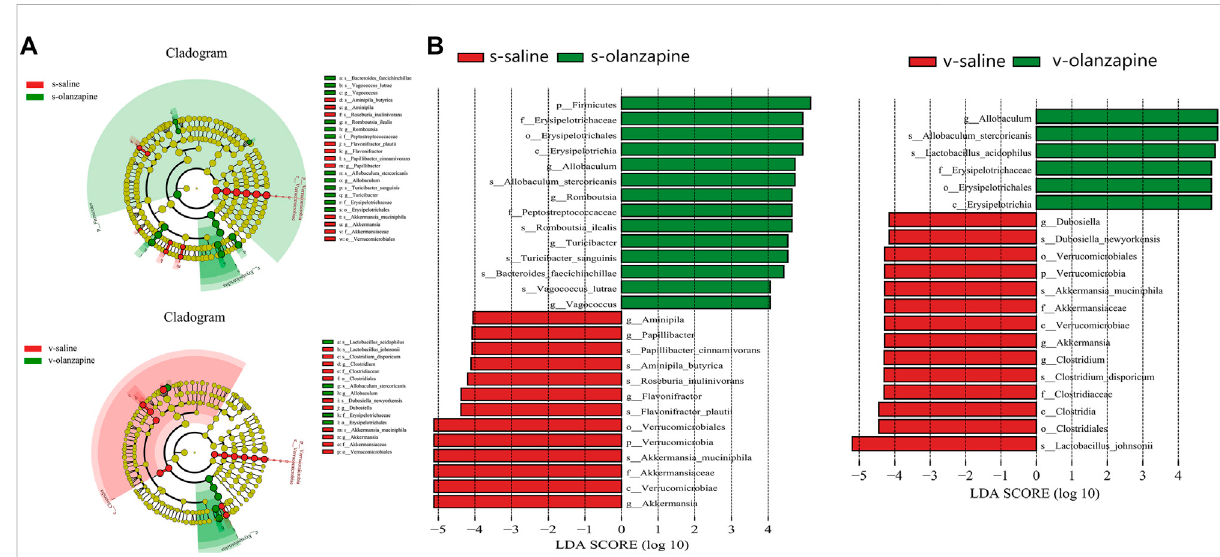
FIGURE 4 The LEfSe cladogram maps the distinct bacterial taxa between pairwise groups into a taxonomic tree (A) . The rings from inside to outside representtaxonomiclevelsfromphylumtospecies.Thediameterofeachcircleisproportionaltotheabundanceoftaxa.Colorsofcirclesandshades indicate microbial lineages enriched in the corresponding samples, and p, c, o, f, g, and s stand for represent phylum, class, order, family, genus, and species, respectively. (B) Histograms of LEfSe LDA scores for different branches between groups. Only taxa with LDA values greater than 4 are shown. Colors (red or green) indicate that taxa are enriched in the corresponding taxa. The letters p, c, o, f, g, and s represent phylum, class, order, family, genus and species,